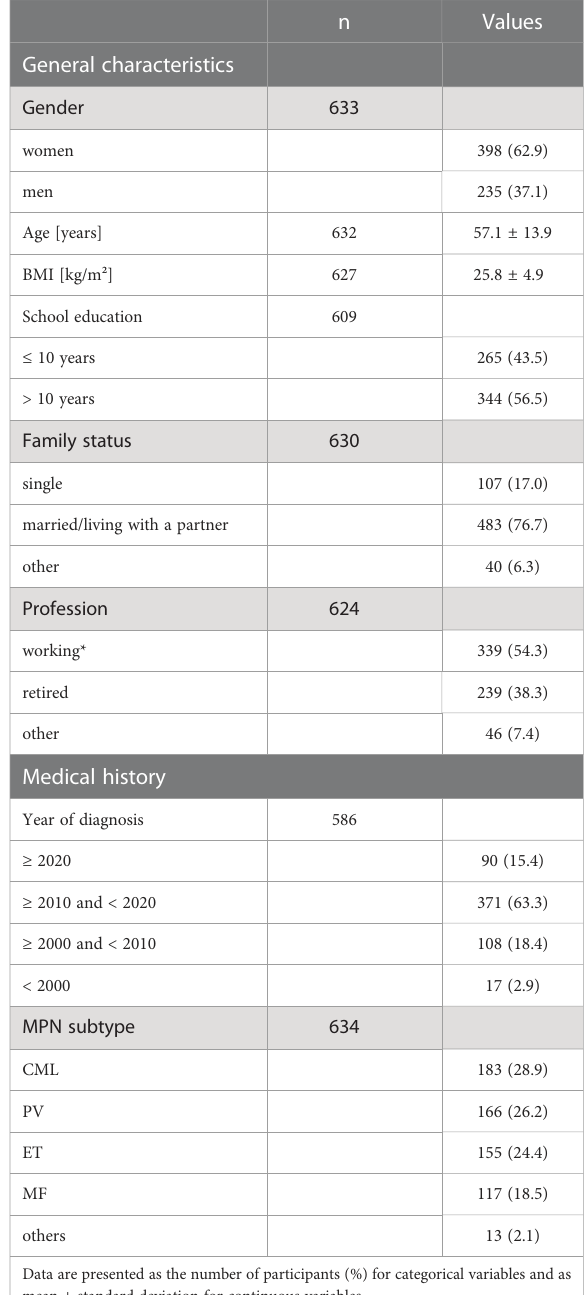
TABLE 1 Sample characteristics (n =